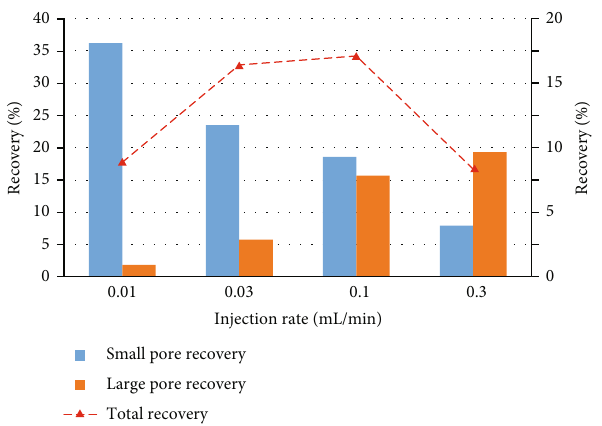
Figure 10: Impact of injection rates on recovery.